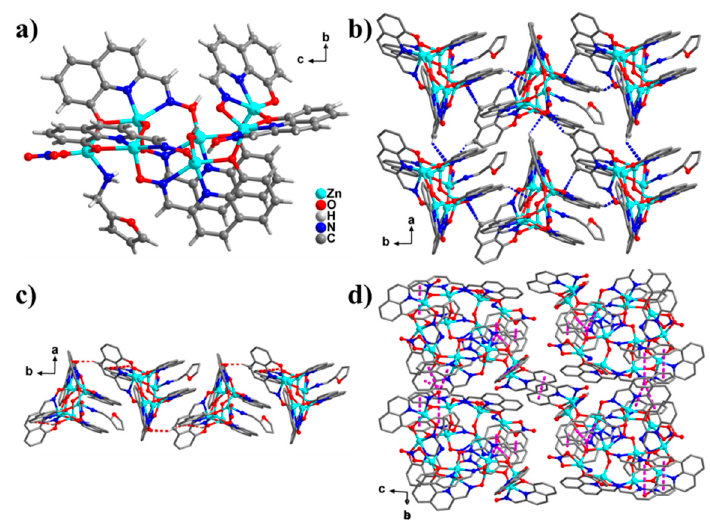
Figure 1. ( a ) The structure of complex 1 ; ( b ) the C-H ··· O weak interactions (blue dotted lines); ( c ) the C-H ··· π weak interactions (red dotted lines); ( d ) the π ··· π weak interactions (pink dotted lines).